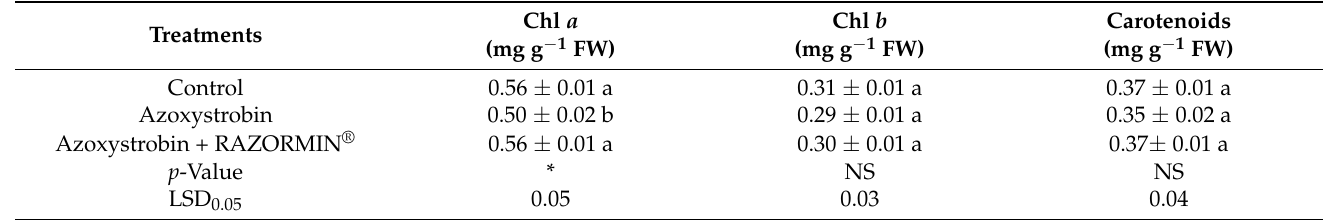
Table 8. Effect of the application of biostimulant RAZORMIN ® on the leaf concentration of photo- synthetic pigments in pepper plants subjected to the fungicide